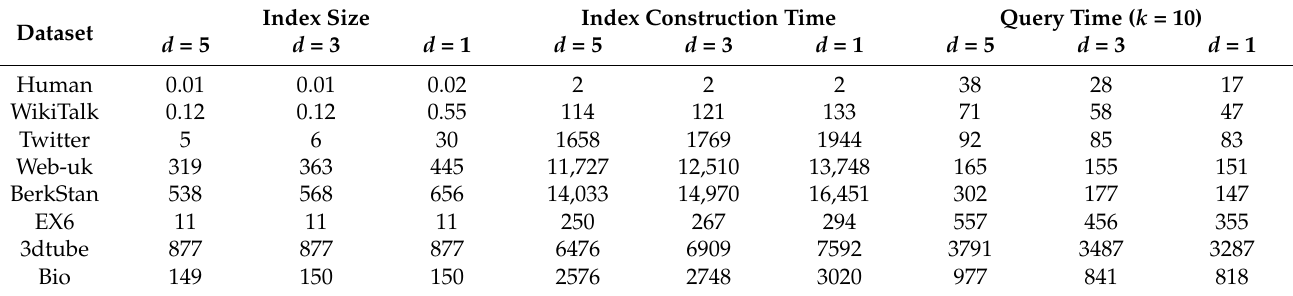
Table 4. Impacts of d on index size (MB), index construction time (ms), and query time